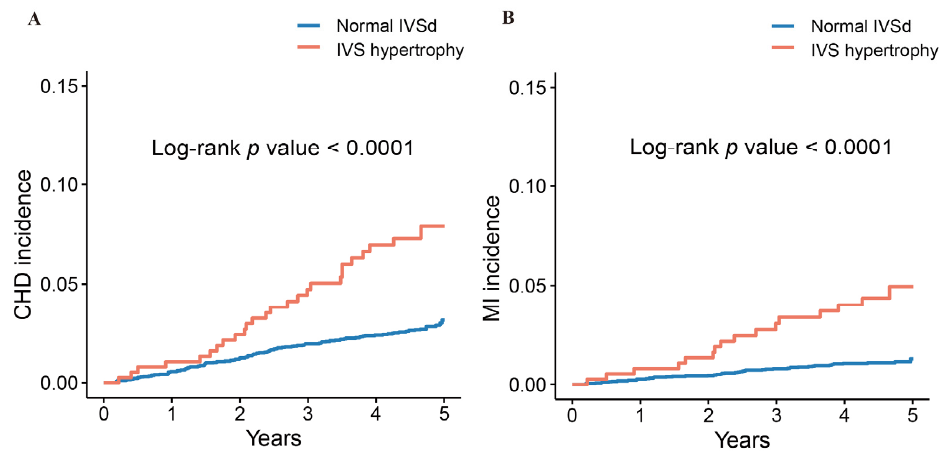
Figure 1. Kaplan–Meier survival curves for CHD incidence ( A ) and MI incidence ( B ) in overall population according to IVSd. CHD, coronary heart disease; MI, myocardial infarction; IVSd, interventricular septum thickness; IVS Hypertrophy, Interventricular septum hypertrophy.